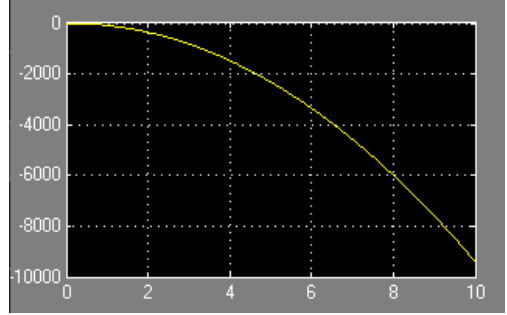
Fig 9. The simulation result without using any algorithm